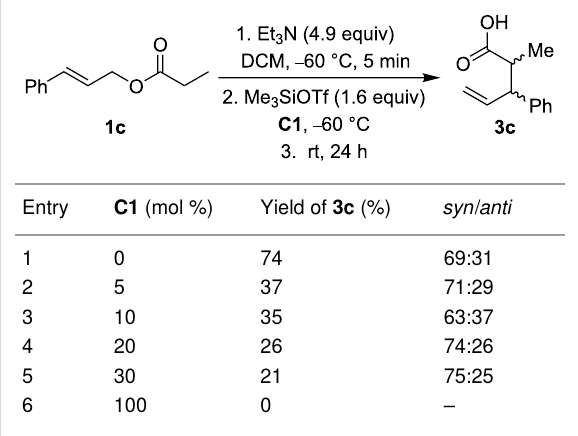
Table 3: Effect of catalyst loading on the Ireland–Claisen rearrange- ment of 1c .